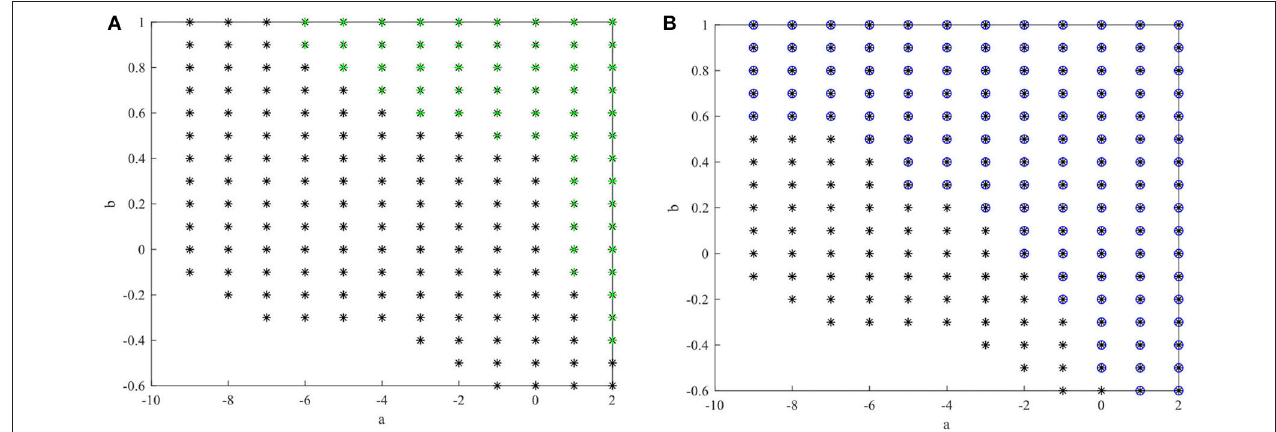
Frontiers in Neurorobotics |